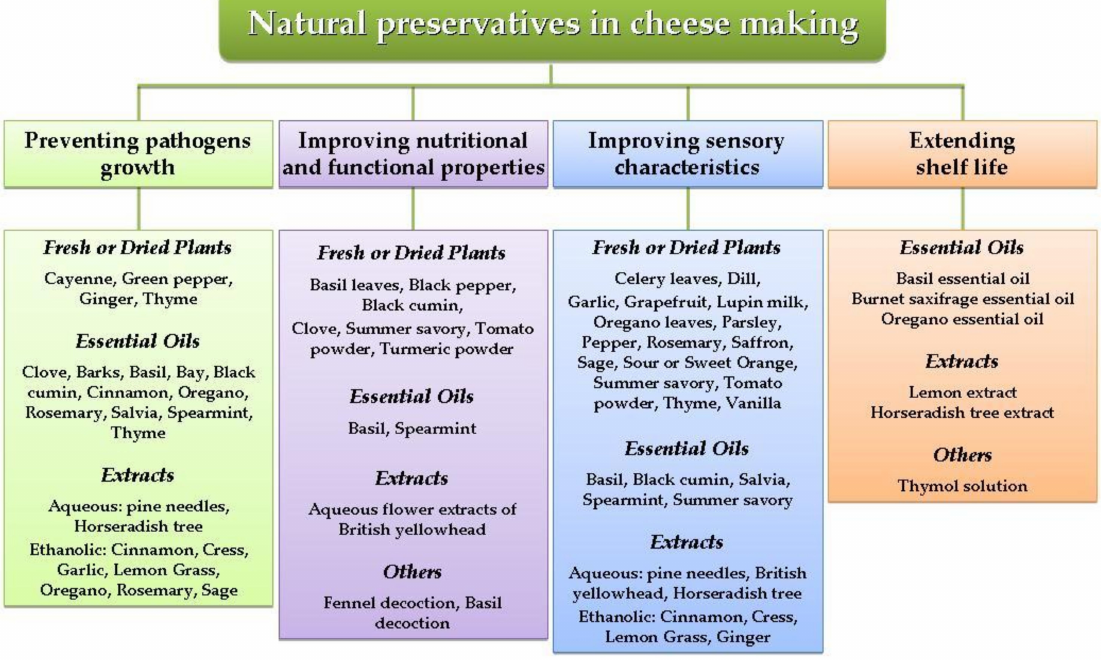
Figure 1. Major plants and their applications in cheese